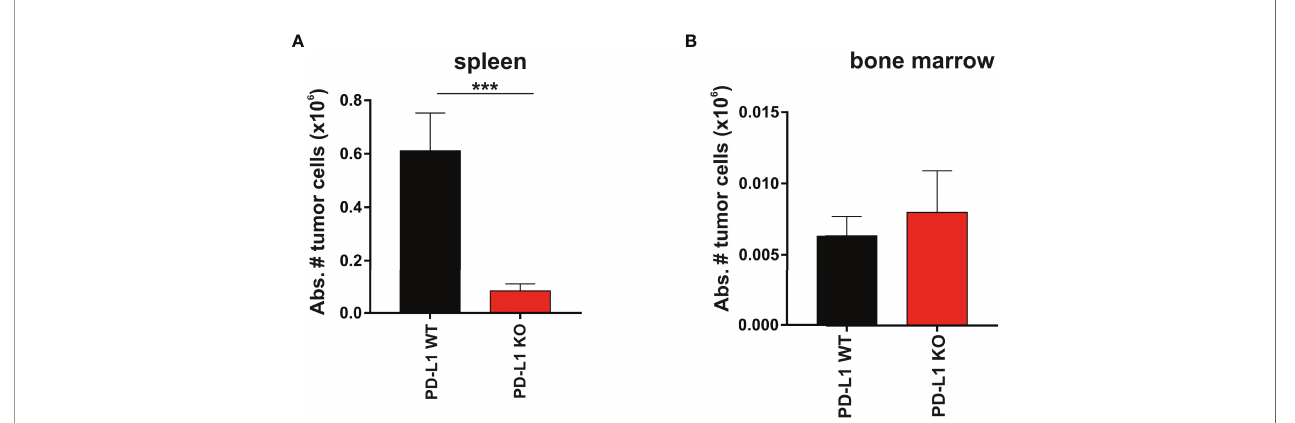
FIGURE 3 | Superior engraftment of A20 PD-L1 WT tumor cells compared to A20 PD-L1-de fi cient tumor cells in the spleen of F1 recipients contrasted with the bone marrow resistance to tumor implantation of either tumor cell line. (A) Bar plot shows the absolute number of PD-L1 WT and PD-L1 KO leukemia cells in the spleen calculated at the time of the euthanasia (day 30 after tumor implantation). Tumor cells (K b − /K d+ ) were distinguished from non-tumor cells (host cells, K b+ /K d+ ) by fl ow cytometry. (B) The absolute number of PD-L1 WT and PD-L1 KO leukemia cells in the bone marrow of F1 recipients was also monitored